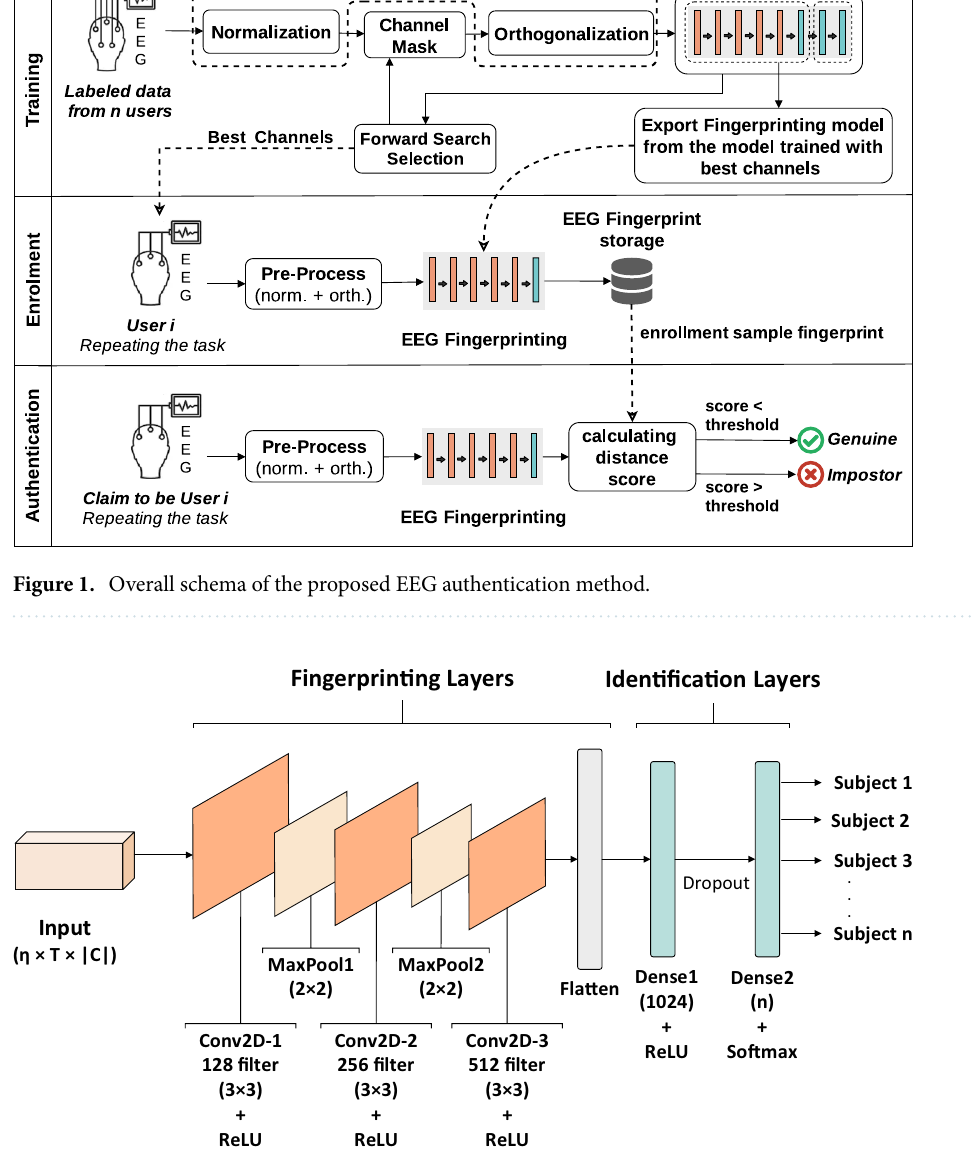
Figure 2. Layers of the proposed CNN identification